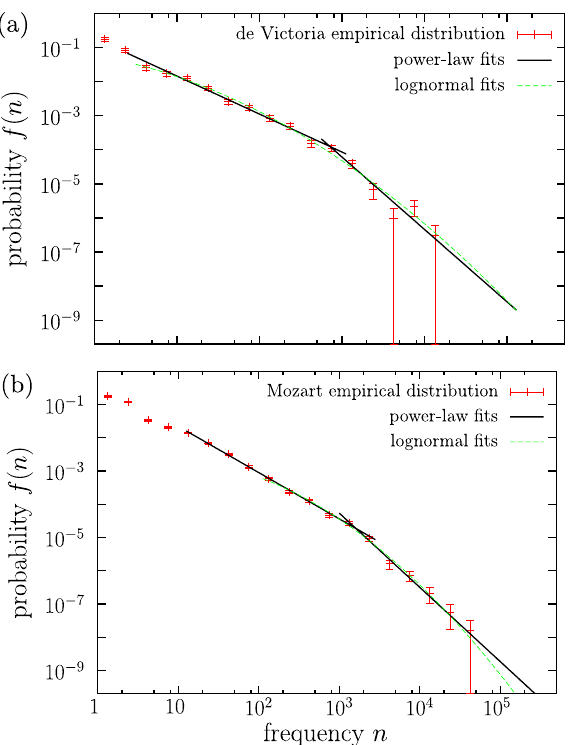
Figure 3. Empirical probability density of codeword frequency for ( a ) de Victoria and ( b ) Mozart, together with double power-law and lognormal fits. Among all the composers, de Victoria and Mozart yield the largest logarithmic span of the fitting range, n max / a , for the double power law. Note that de Victoria also yields the lognormal fit with the largest n max / a (comparable to the value for the double power